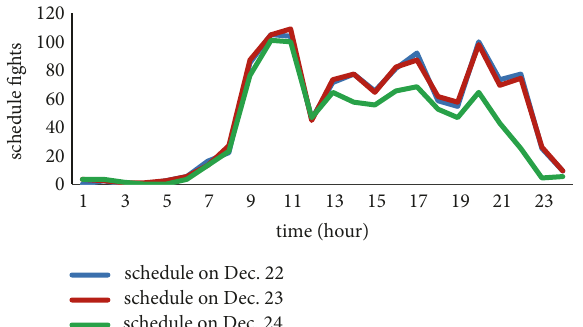
Figure 10: Comparison between Δ𝑑 on typical congestion